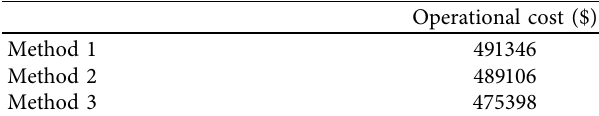
Table 3: The total operational cost of different scheduling models.